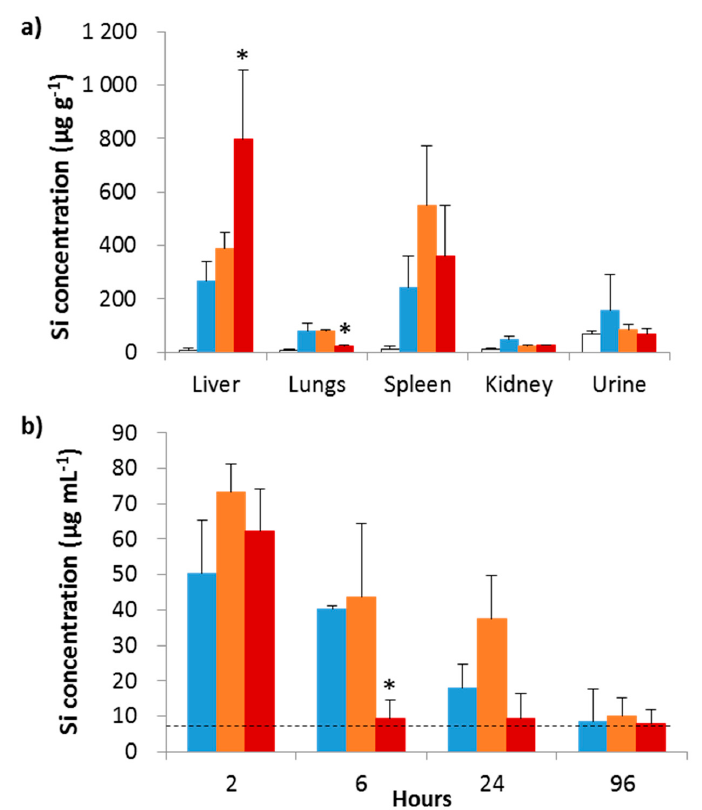
Figure 5. Biodistribution of Fe 3 O 4 @MSN in mice. ( a ) Quantification of silicon in different organs